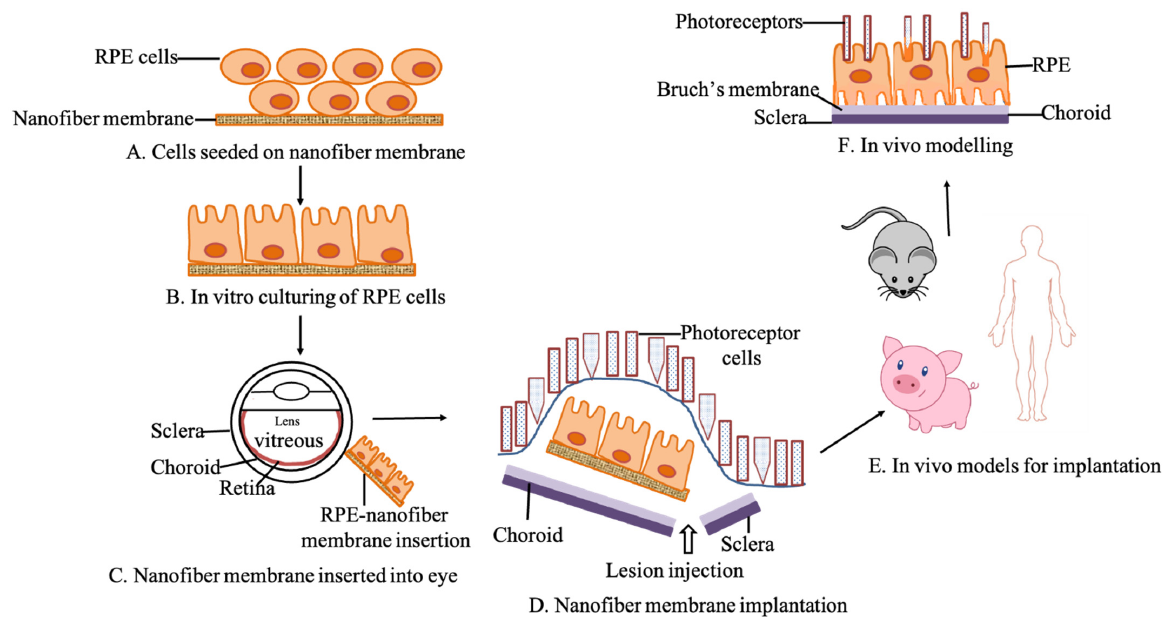
Figure 1. Schematic of RPE tissue engineering strategy.